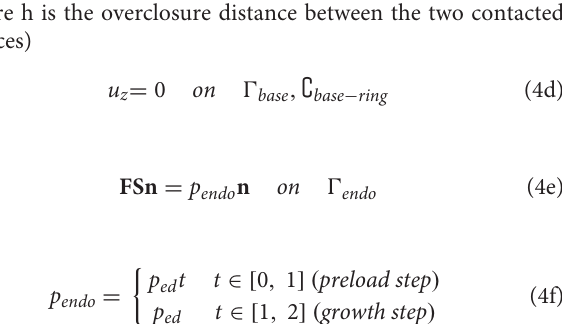
(where u is displacement and ˙ u is velocity, the superscript ( i ) indicates the increment number and i − 1 mid-increment